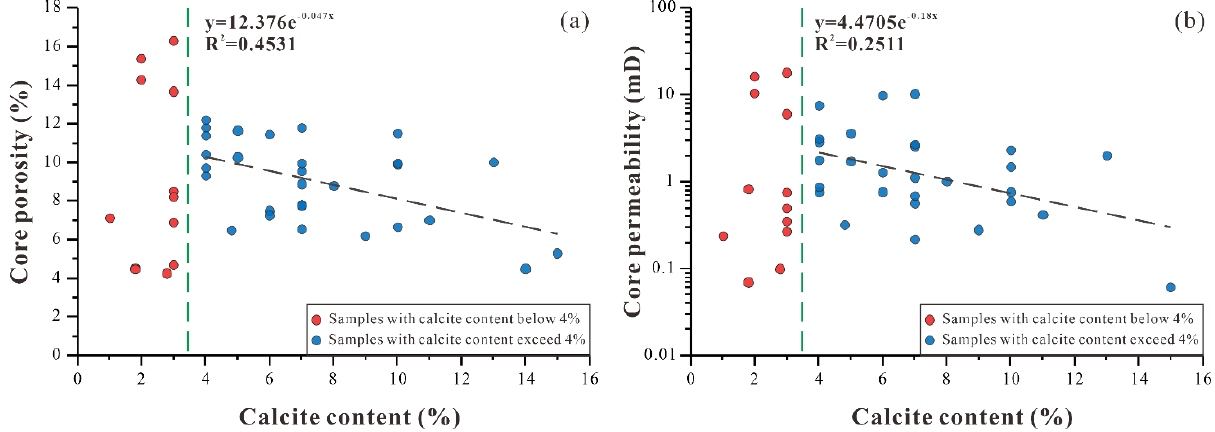
Figure 14. Relationship between calcite and the reservoir physical properties of the Lower Jurassic reservoir in the Niudong area, northern margin of Qaidam Basin: ( a ) calcite content and porosity; ( b ) calcite content and permeability.